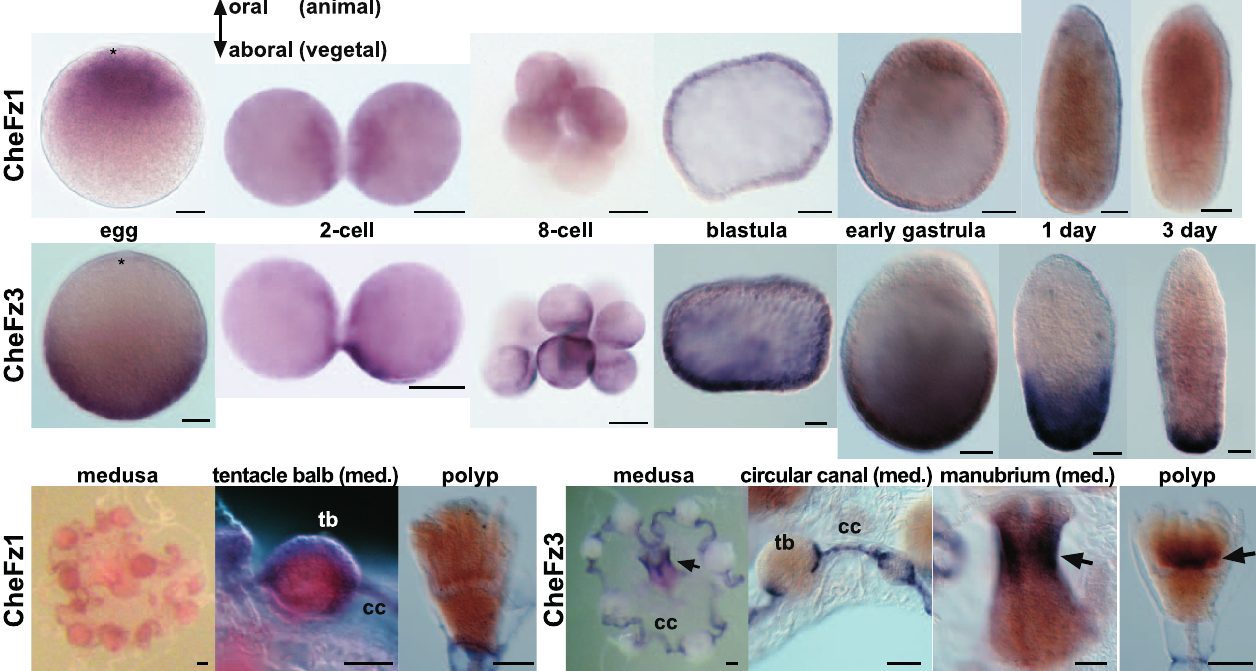
Figure 2. Opposing Localisation of CheFz1 and CheFz3 RNAs during Early Development In situ hybridisation of C. hemisphaerica eggs, embryos, and planula larvae (fixed at 1 and 3 d after fertilisation), showing the concentration of CheFz1 RNA (top row) in the animal cytoplasm of the egg and around the nuclei during first cleavage, and its graded oral–aboral distribution in blastula and early gastrula stages. CheFz1RNA levels declined during gastrulation and subsequently remained low throughout all regions, with some increase in the oral endoderm during planula development. CheFz3 RNA (middle row) was localised strongly to the vegetal egg cortex, becoming concentrated in the vegetal part of the cleavage furrow during cytokinesis, and then to the presumptive aboral pole throughout embryonic and larval development. Asterisks mark nuclei in eggs. In medusa and polyp stages (bottom row), low levels of CheFz1 RNA were detected in all regions, including the tentacle bulb (tb), while CheFz3 RNA was detected strongly in specific regions of the endoderm: the circular canal (cc) and a juxta-oral band of the manubrium (arrows). All embryos and polyps are oriented with the oral pole pointing up. Bars ¼ 40 l